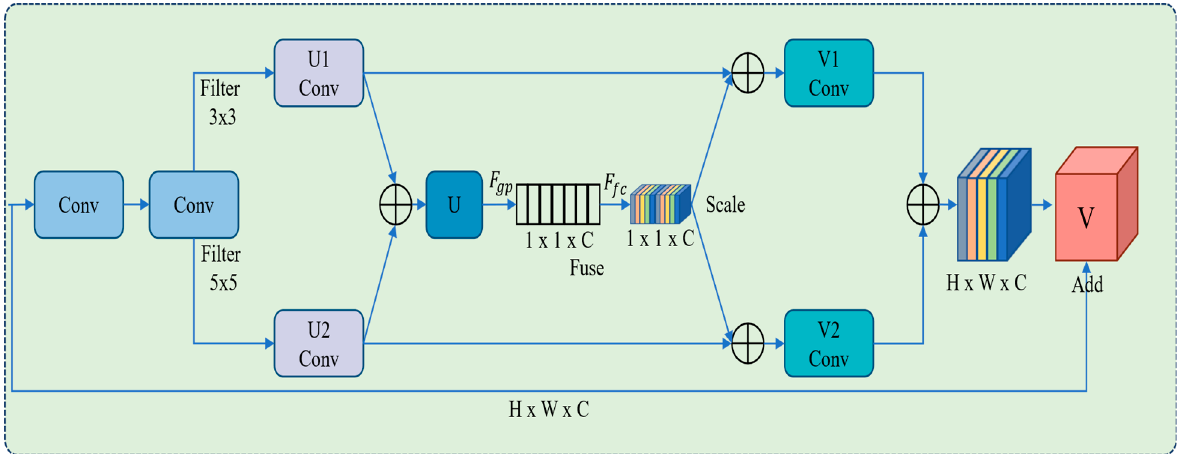
Figure 4. Represents the internal architecture of the modified SK attention module of the proposed work.